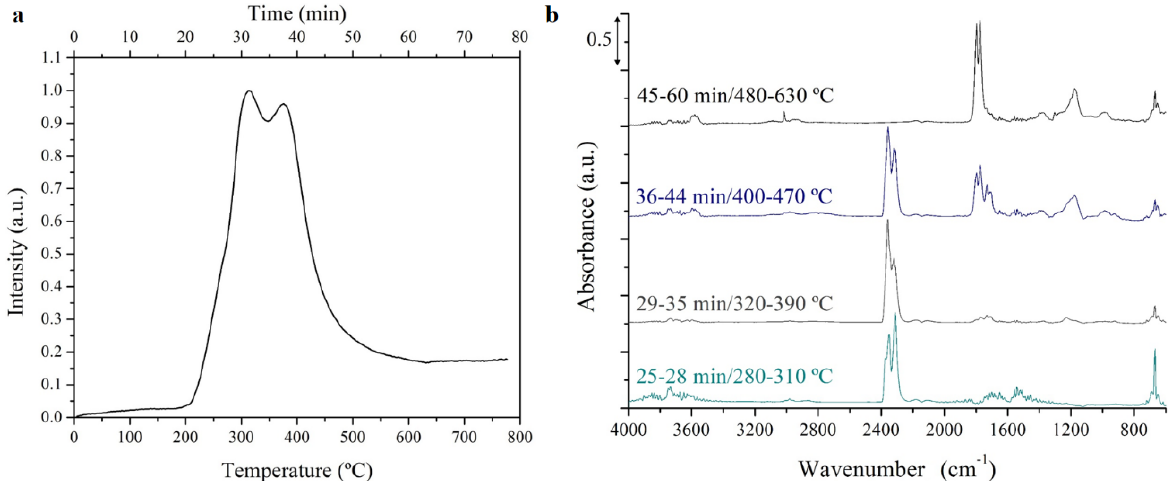
Figure 11. ( a ) Gram–Schmidt over time and temperature and ( b ) FTIR spectra recorded at different intervals for PE0 sample.